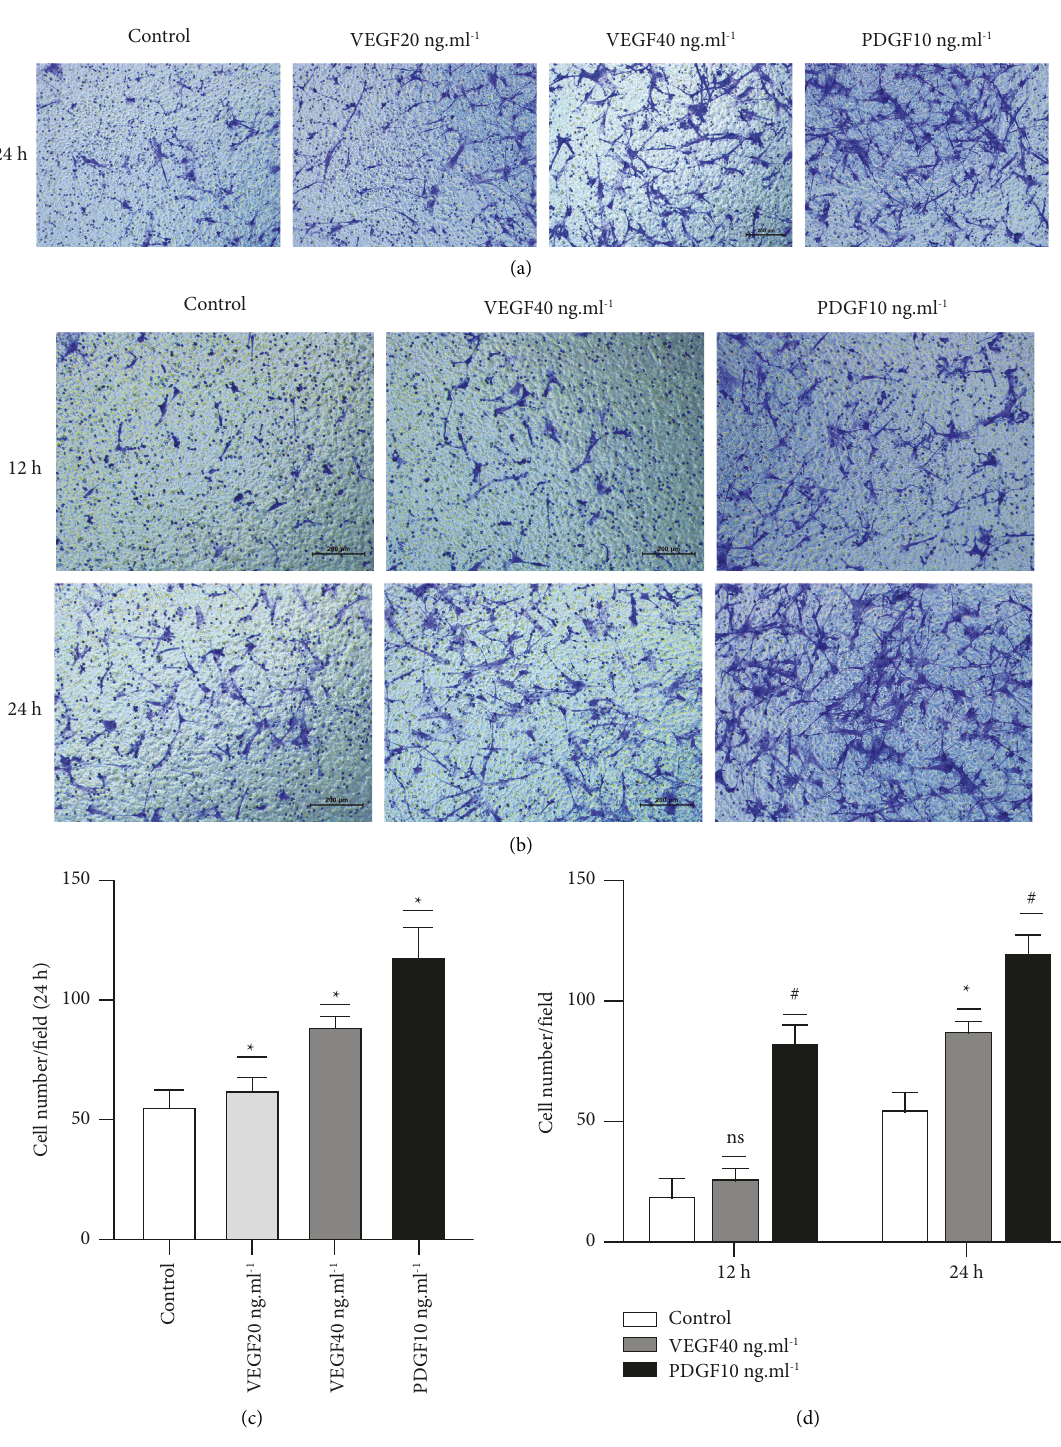
Figure 4: Transwell assays detected the effect of VEGF on ASMC migration. (1) Transwell assays detected VEGF 20ng · ml − 1 in the control, VEGF 40ng · ml − 1 , and PDGF 10 ng · ml − 1 groups. The effect of group on ASMC migration; PDGF 10 ng · ml − 1 was used as the positive control group. (a) A representative picture. (b) The histogram shows the number of migrating cells in each group, and the data are expressed as the mean ± standard deviation (M ± SD). (2) Transwell assays were used to detect the effect of VEGF (40ng · ml − 1 ) and the control group on ASMC migration at 12 and 24h. (c) A representative picture. The histogram in (d) shows the number of cells that migrated in the control and VEGF 40ng · ml − 1 groups at 12 and 24h, and the data are expressed as the mean ± standard deviation (M ± SD). NS indicates that the difference between groups is nonsignificant ( P > 0 . 05), ∗ P < 0 . 05, and the difference between groups was significant ( P < 0 .